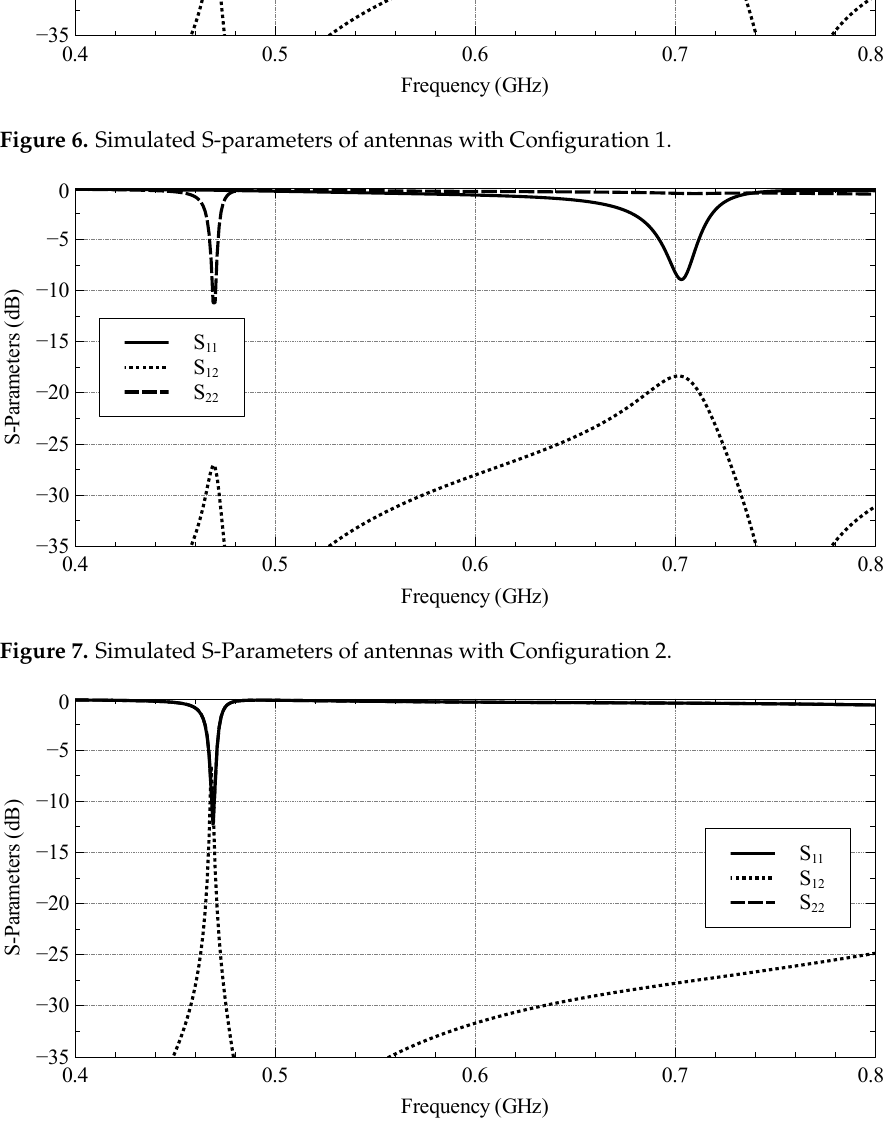
Figure 8. Simulated S-Parameters of antennas with Configuration